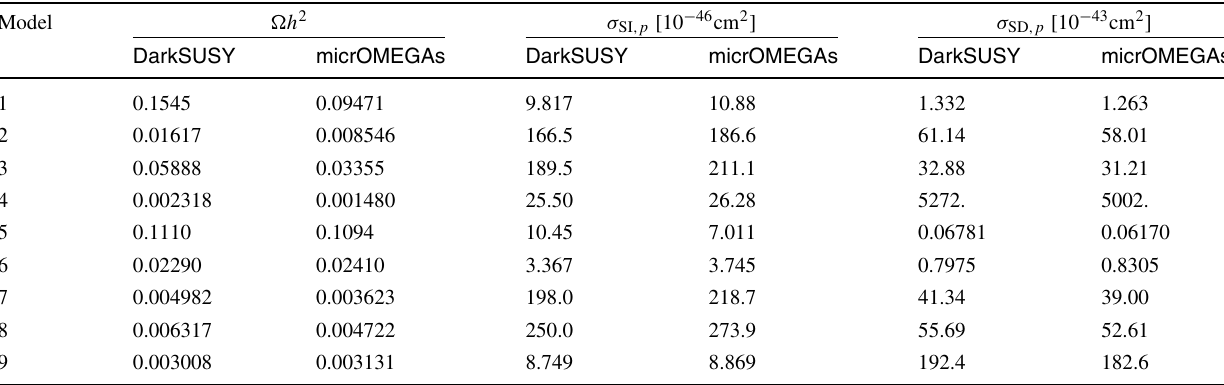
Table 12 The dark matter relic density and proton-scattering cross- sections, both spin-independent and spin-dependent, for a range of MSSM model points. The model points are defined in Table 11.